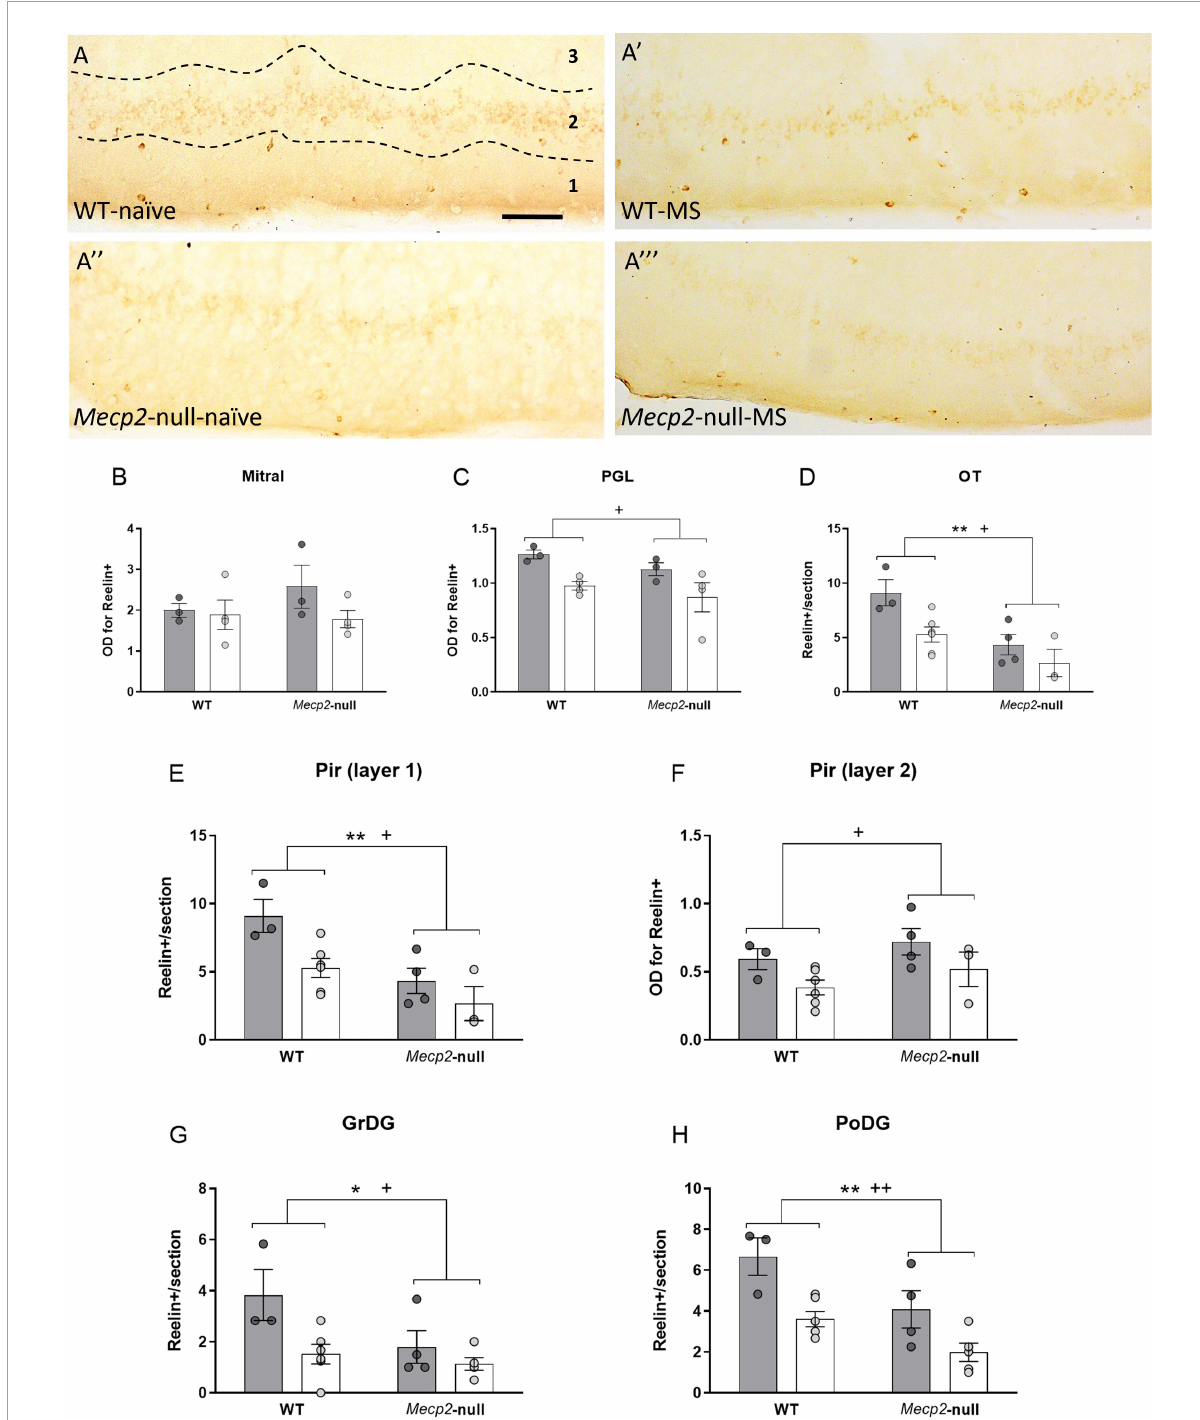
FIGURE6 Both MS and the lack of Mecp2 reduce the expression of reelin. (A) Representative photomicrographs from reelin immunostaining (dark-brown, revealed with DAB) at the Pir from WT-naïve (A) , WT-MS (A’) , Mecp2 -null-naïve (A”) and Mecp2 -null-MS (A”’) ; scale bar represents 100 µ m. Note that while the positive signal in the Pir layer 1 is restricted to a population of cellular bodies, the distribution in Pir layer 2 is diffuse. Reelin-ir in the OB (B) and the PGL (C) . Number of reelin immunopositive cells per section at the OT (D) and layer 1 of the Pir (E) and reelin-ir in layer 2 of the Pir (F) . Reelin-ir cells in the (G) GrDG and (H) PoDG. In all cases, graphs represent individual values and mean ± SEM. * p < 0.05, ** p < 0.01 by genotype; + p < 0.05, ++ p < 0.01 by group. GrDG, granular cell layer of the dentate gyrus of the hippocampus, OT, olfactory tubercle; PGL, periglomerular layer of the olfactory bulb; Pir, piriform cortex; PoDG, polymorph cell layer of the dentate gyrus of the